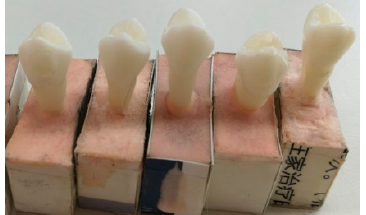
Figure 1. Some prepared specimens in cardboard boxes.